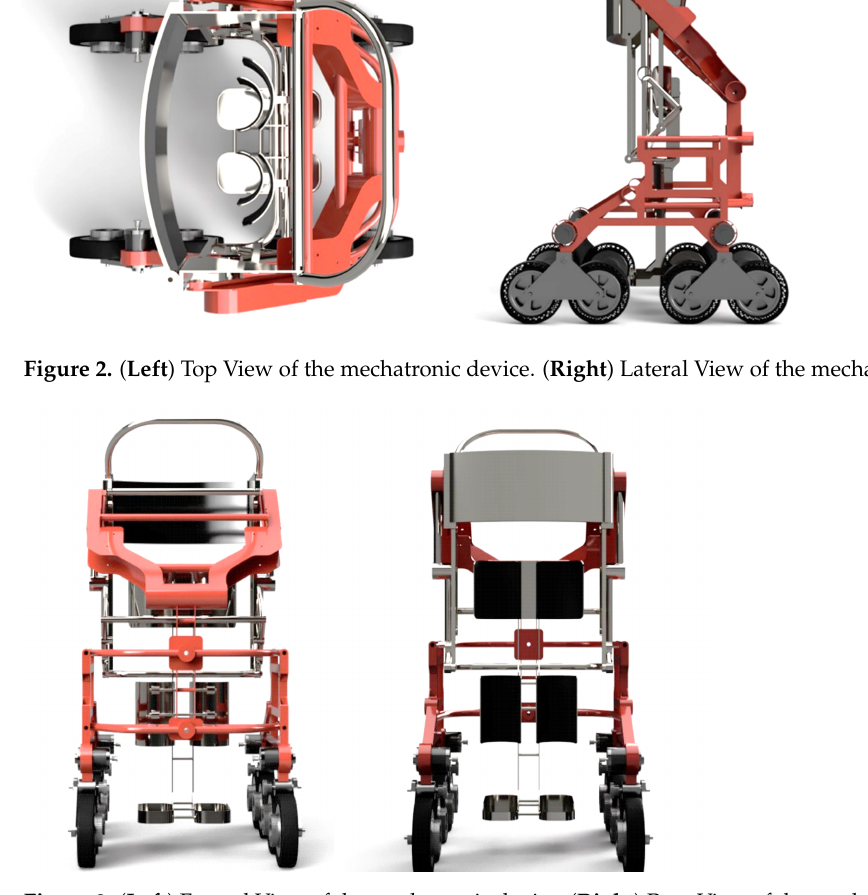
Figure 3. ( Left ) Frontal View of the mechatronic device, ( Right ) Rear View of the mechatronic device.